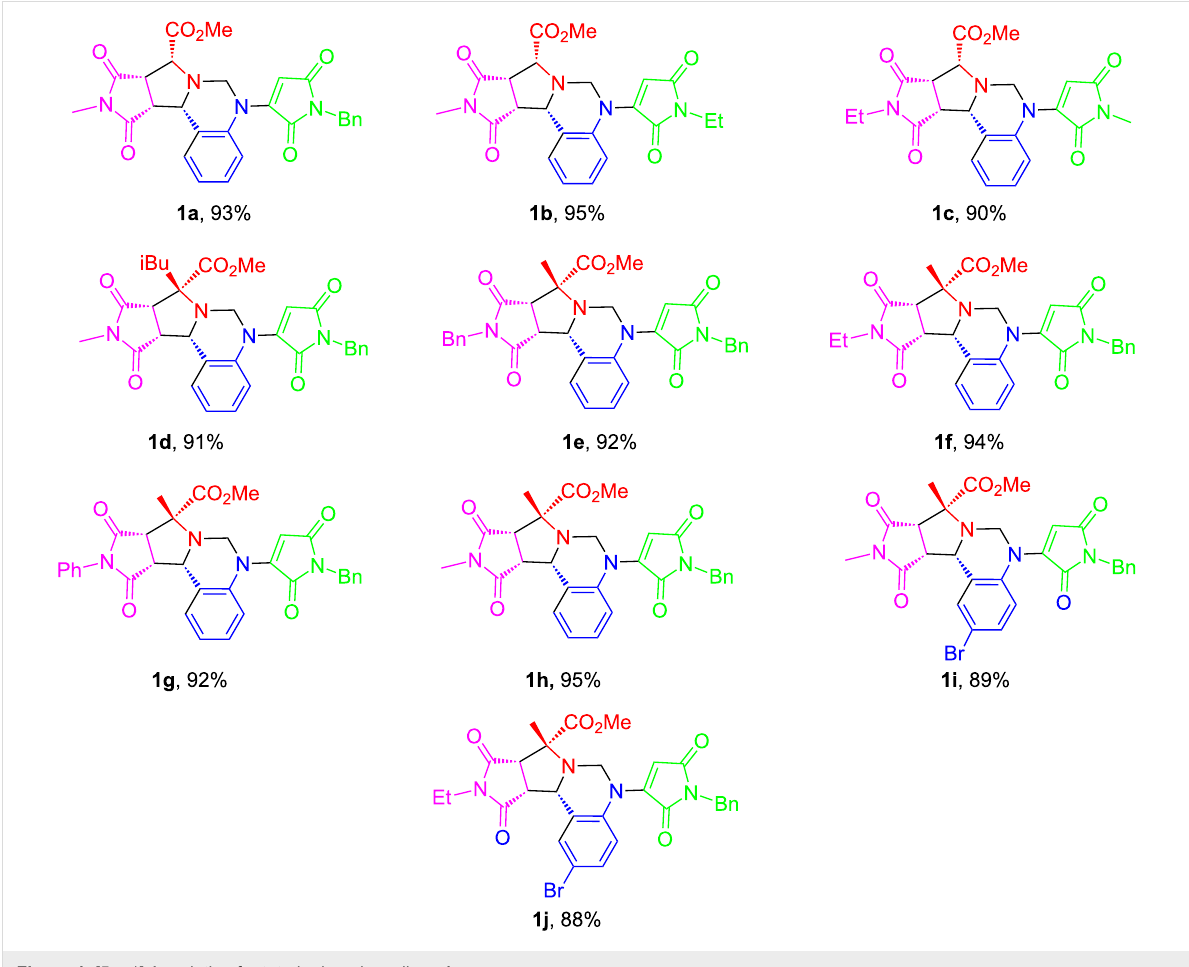
Figure 4: [5 + 1] Annulation for tetrahydroquinazolines 1